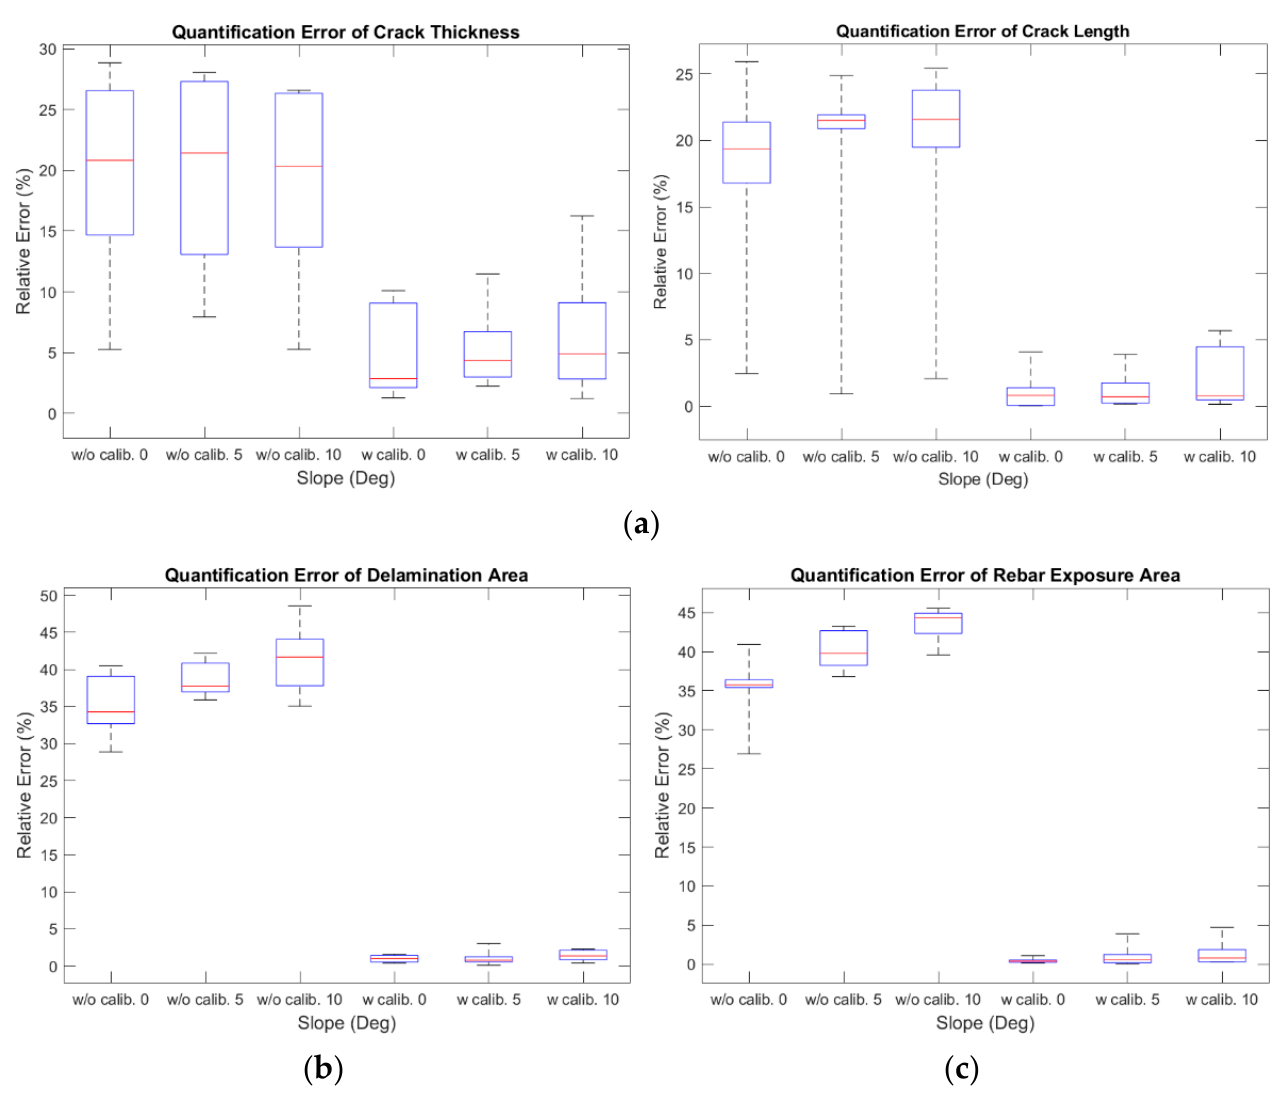
Figure 11. Boxplot of quantification results of structural damage by type. Relative error of: ( a ) thickness and length of